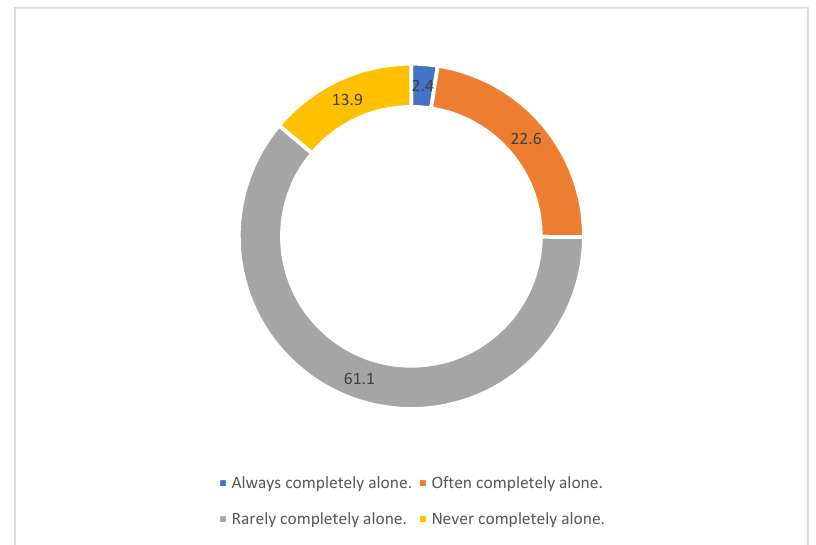
Figure 5. Loneliness.